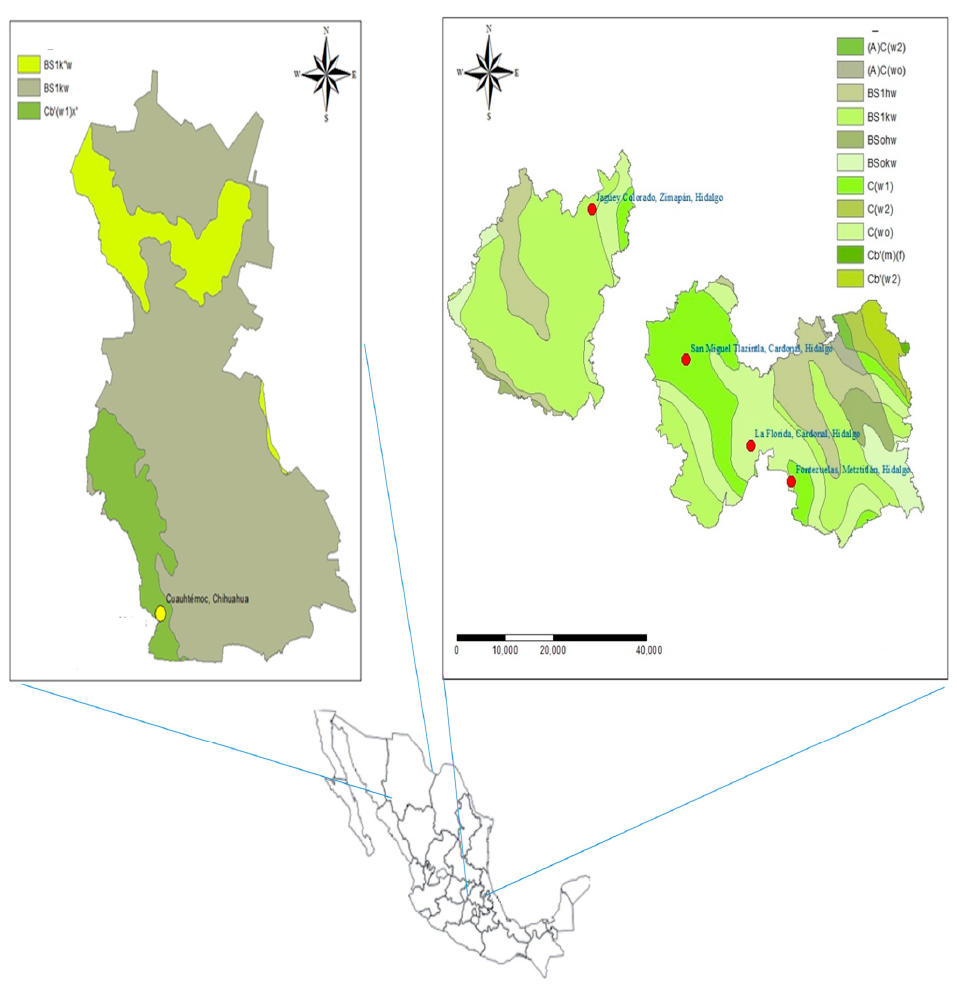
Figure 4. Distribution map of the five populations of P. cembroides . Source: Own elaboration from the set of climatic vector data from INEGI, 2013 (unit scale 1:100,000).